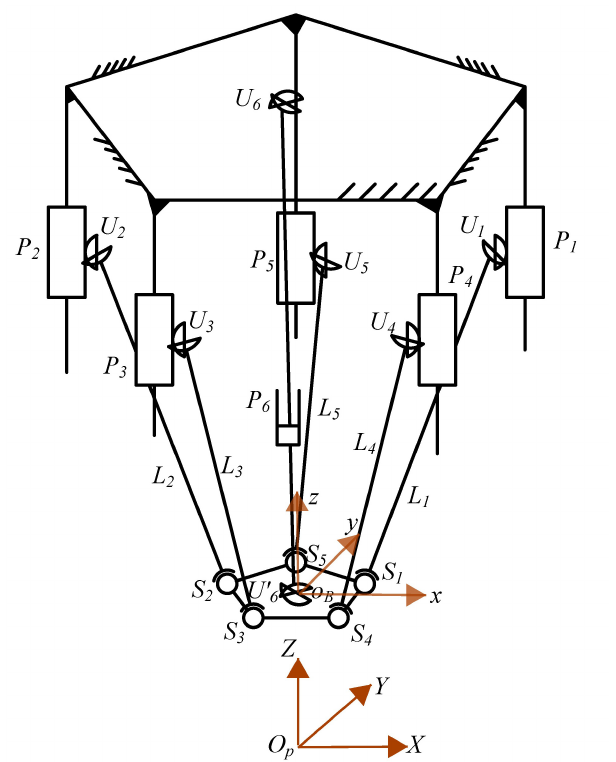
Figure 1. Design sketch of parallel